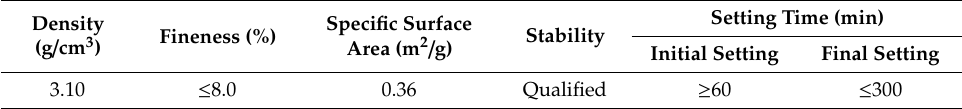
Table 1. The physical properties of Portland cement.